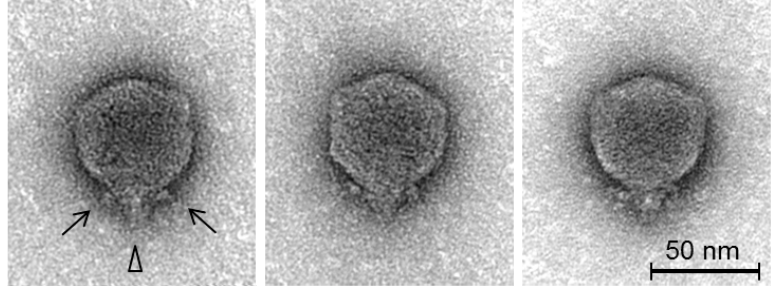
Figure 2. Transmission electron microscopy of negatively stained Pectobacterium phage CB5 using 1% (w/v) uranyl acetate. Triangle indicates the short conical tail structure, and arrows indicate short appendages (whiskers) beneath the capsid. Scale bars represent 50 nm.